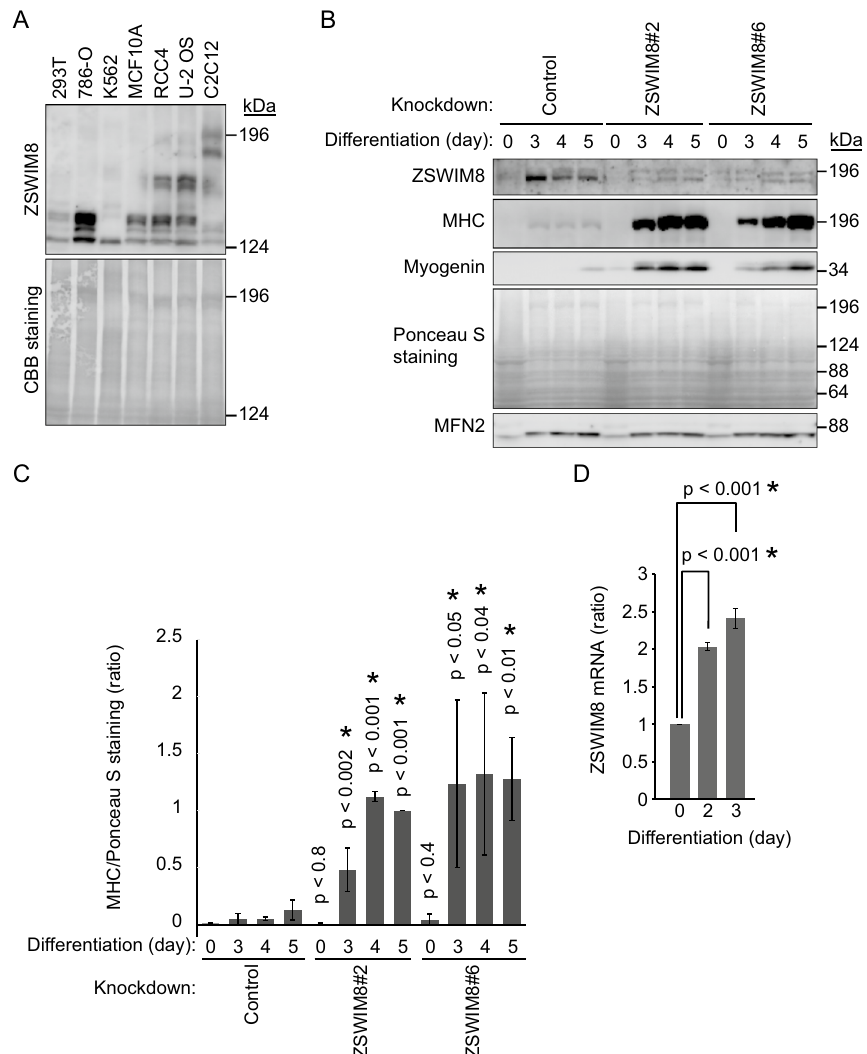
Figure 1. Prevention of C2C12 differentiation by ZSWIM8. ( A ) Expression of ZSWIM8 in C2C12 myoblasts. ZSWIM8 expression in several cell lines was examined. Ponceau S staining rather than a particular protein, such as tubulin or actin, was used as a loading control. The expected ZSWIM8 molecular weight is 197,781 Da. ( B ) Prevention of C2C12 differentiation by ZSWIM8. Control or ZSWIM8-knockdown (#2 and #6) C2C12 cells were differentiated for 3, 4, or 5 days. The cell lysates were subjected to immunoblotting with an anti-ZSWIM8, myosin heavy chain (MHC), or myogenin antibody. Mitofusin 2 (MFN2) and Ponceau S staining were used as loading controls. Representative data of three independent experiments. ( C ) Quantification of MHC expression in ( B ). MHC signals were normalized to that of Ponceau S staining. Expression in ZSWIM8 knockdown#2 cells after 5 days differentiation was set as 1. Data represent the mean ± SD of three independent experiments. ( D ) Induction of Zswim8 mRNA during C2C12 cell differentiation. Zswim8 mRNA expression in growing or differentiated C2C12 cells was measured using quantitative PCR. Expression in growing cells was set as 1. Data represent the mean ± SD of three independent experiments. Asterisk indicates statistical significance compared to the control sample. The membranes in ( A ) and ( B ) were cut prior to hybridization with antibodies. Full- length blots are presented in Supplementary Fig.